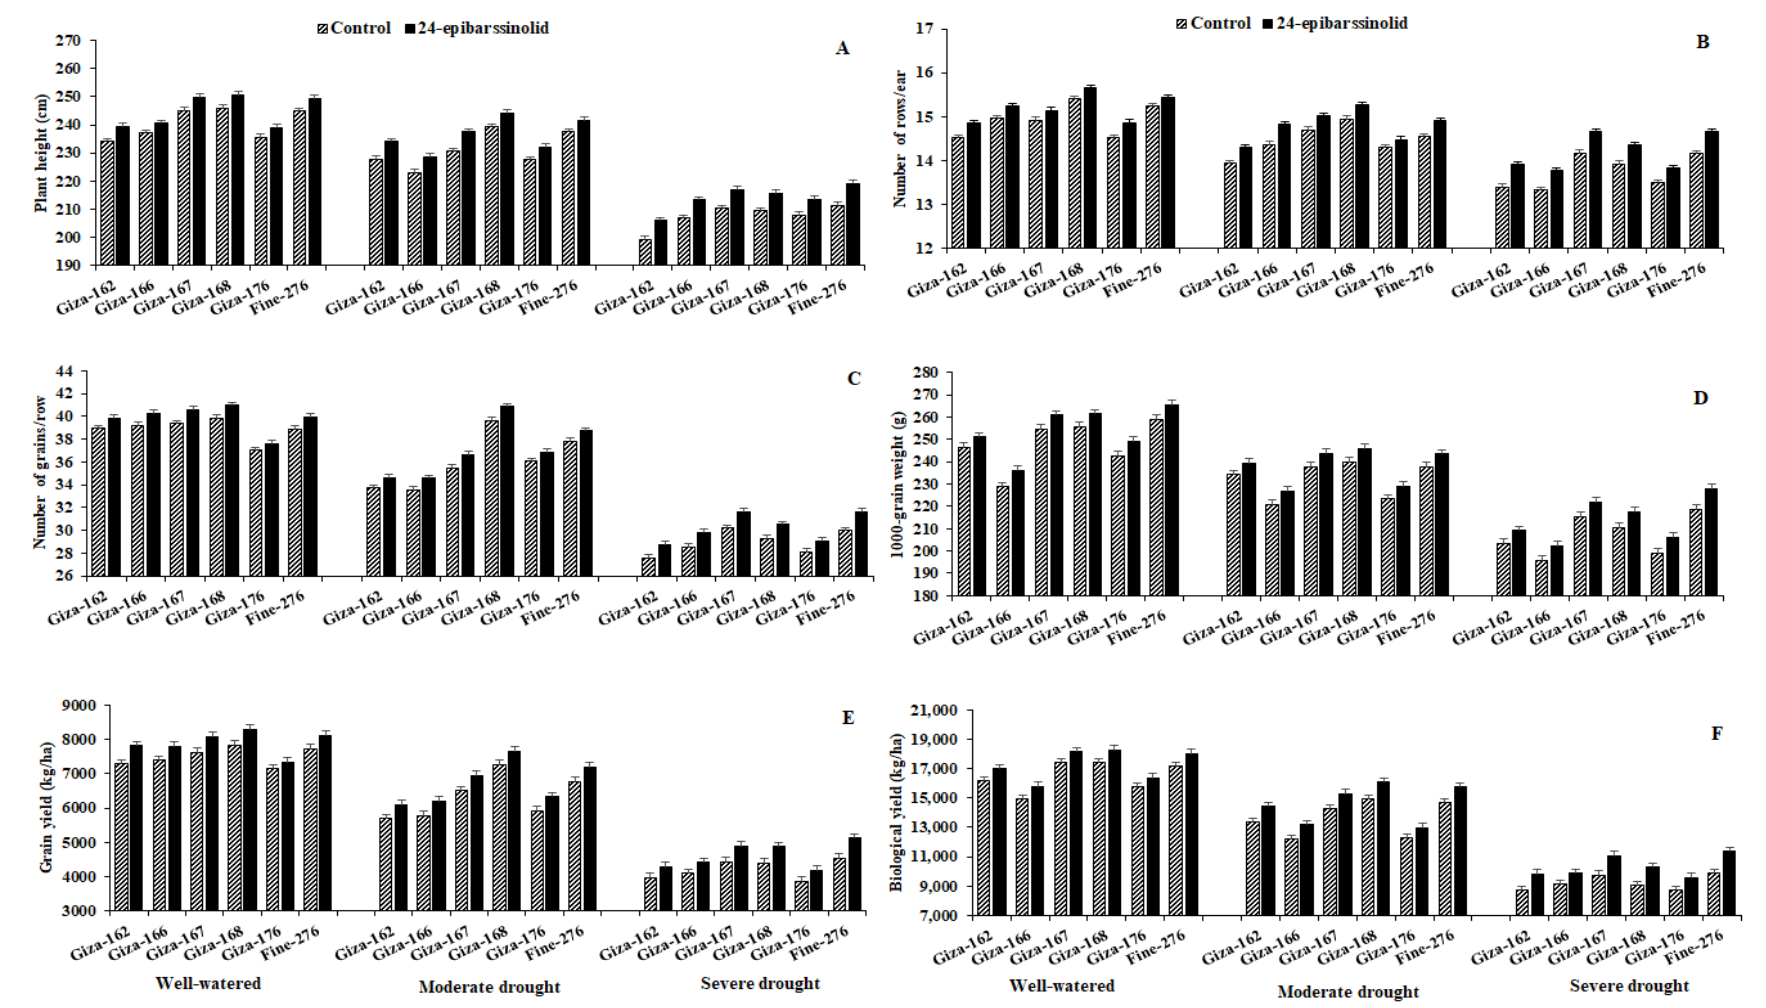
Figure 1. Influence of 24-epibrassinolide application on plant height ( A ), number of rows/ear ( B ), number of grains/row ( C ), 1000-grain weight ( D ), grain yield ( E ) and biological yield ( F ) of six maize hybrids grown under three irrigation regimes over the two growing seasons of 2018 and 2019. The bars on the top of the columns represent the LSD ( p ≤ 0.05).